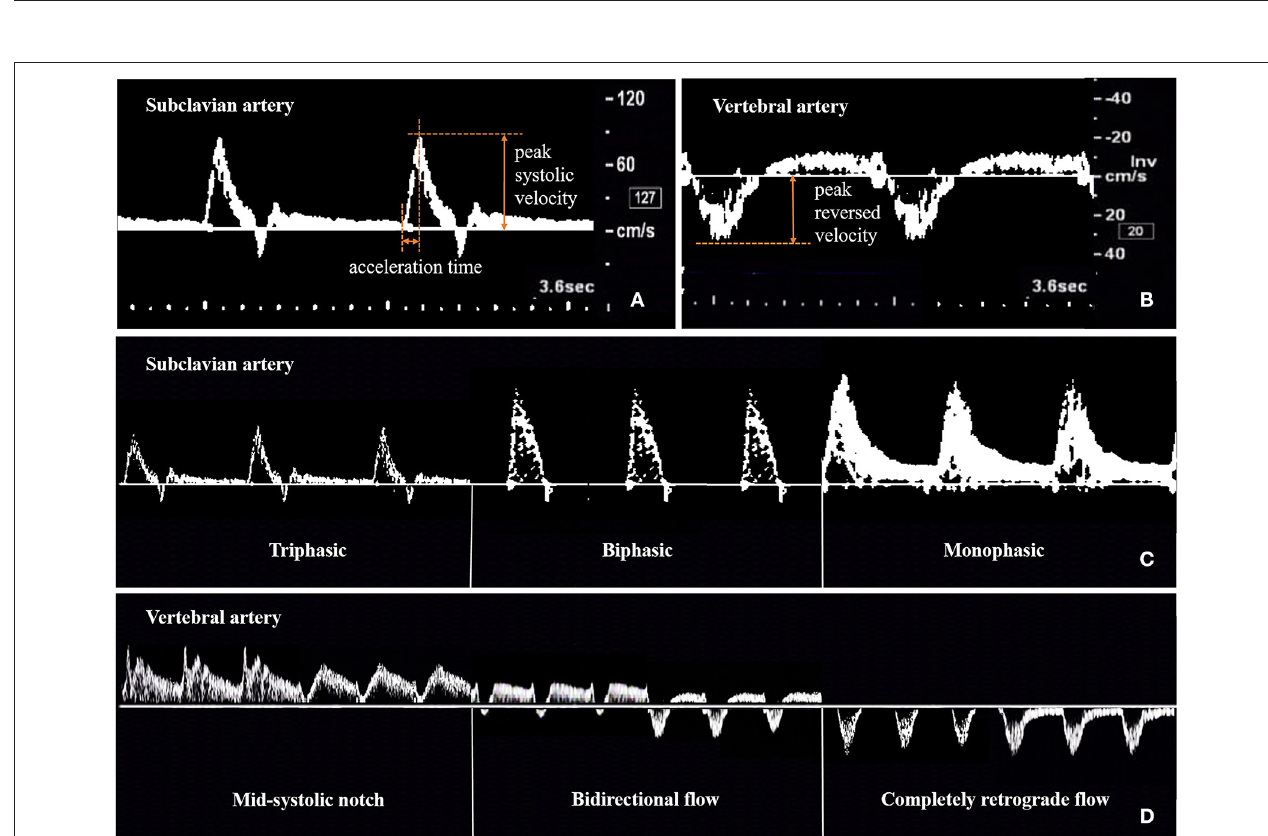
FIGURE 2 | Method for measuring and recording ultrasonic parameters of subclavian artery (A,C) and vertebral artery (B,D) .